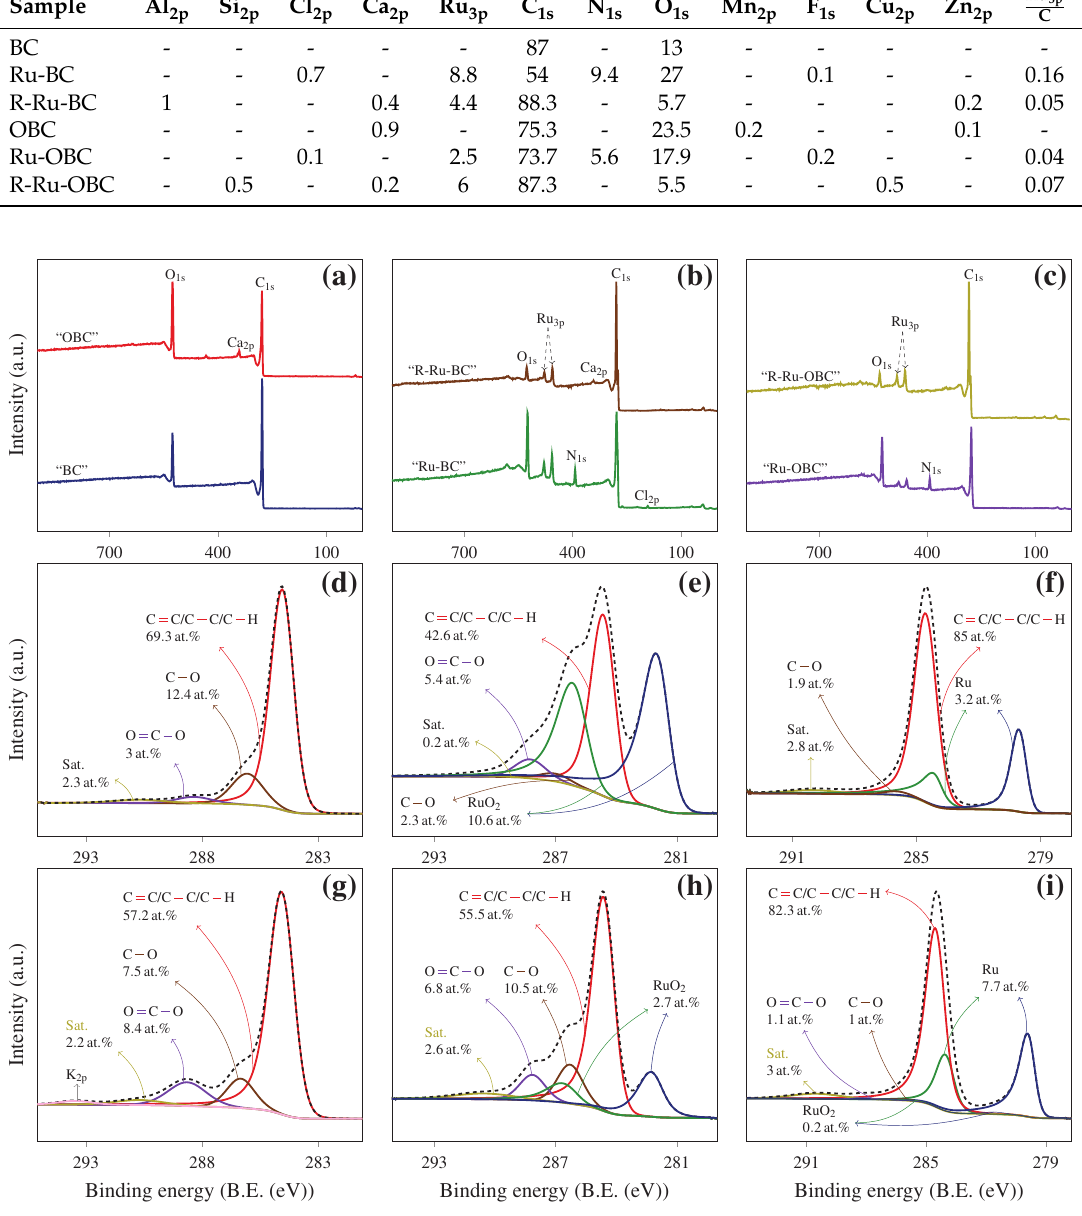
Figure 5. XPS analysis: ( a ) full-range surveys of biochar before and after oxidation (samples “BC” and “OBC”); ( b ) full-range surveys of original biochar, loaded with Ru before and after reduction (samples “Ru-BC” and “R-Ru-BC”); ( c ) full-range surveys oxidized biochar, loaded with Ru before and after reduction (samples “Ru-OBC” and “R-Ru-OBC”); ( d ) C 1s deconvolution of sample “BC”; ( e ) C 1s deconvolution of sample “Ru-BC”; ( f ) C 1s deconvolution of sample “R-Ru-BC”; ( g ) C 1s deconvolution of sample “OBC”; ( h ) C 1s deconvolution of sample “Ru-OBC”; ( i ) C 1s deconvolution of sample